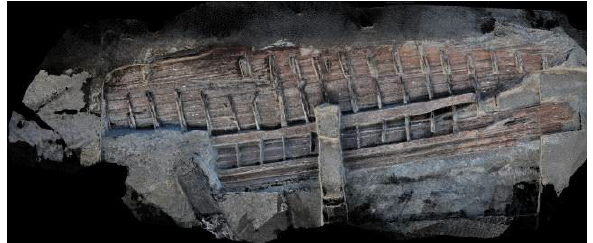
Figure 9. Point cloud from laser scanner.